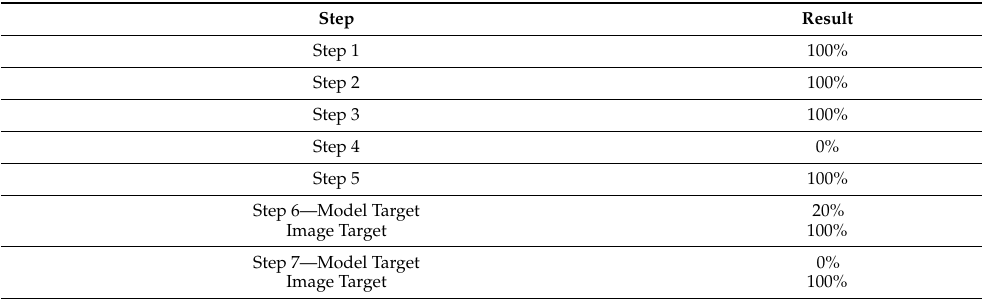
Table 2. Results for test number 3.